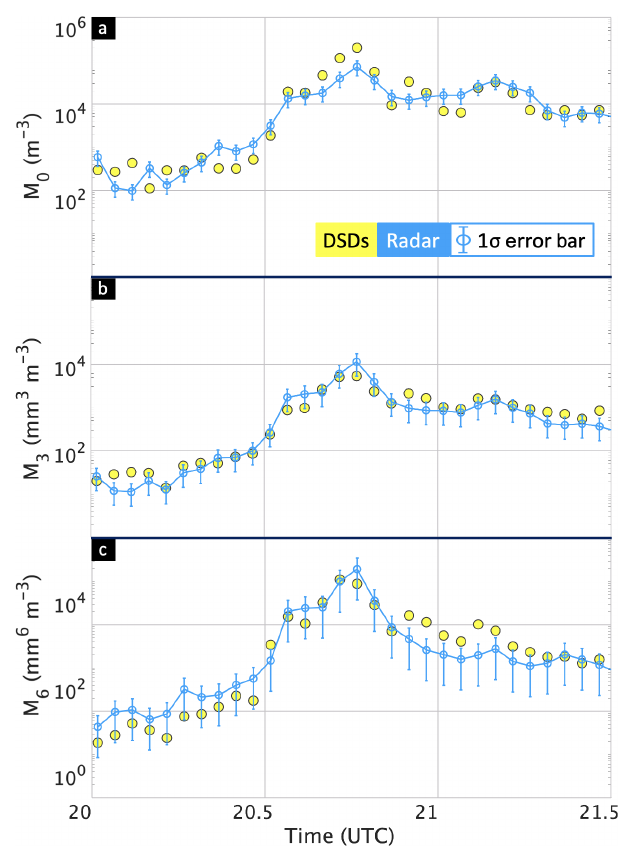
Figure 9. Time series of radar-derived moments and from complete DSDs over the disdrometer site. The radar estimates are mean ± 1 σ error bars. (a) Moment M 0 ; (b) – (c) same but for M 3 and M 6